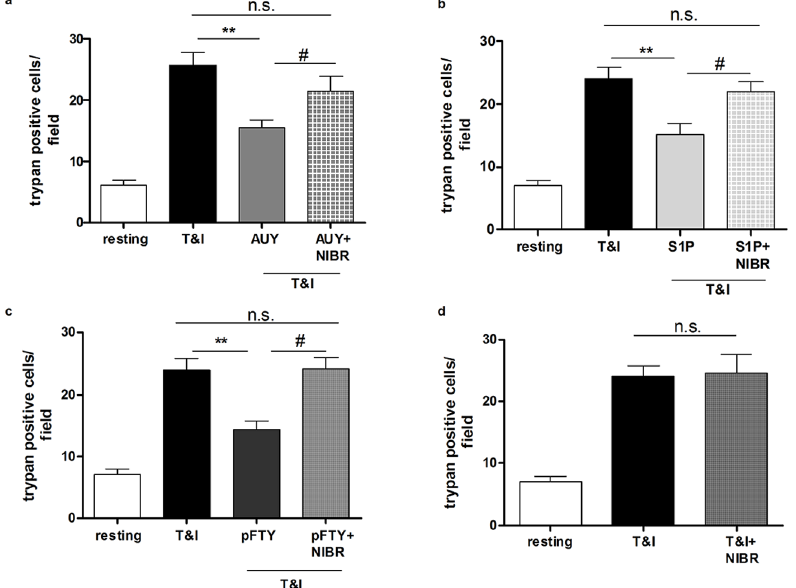
Fig 2. S1P 1 mediates hBMVEC survival after exposure to cytokines. a . The selective S1P 1 agonist, AUY- 954 (AUY, 50 nM) added together with TNF α (10 U/ml) and IFN γ (5 U/ml) (T&I), is able to counteract hBMVEC death induced by cytokines. The presence of S1P 1 selective antagonist NIBR-0213 (NIBR, 1 μ M) prevents this effect entirely. b. and c . The principal involvement of S1P 1 in the protective role of S1P (50 nM) and pFTY (50 nM) is further confirmed by the lack of their effects when used in combination with the antagonist NIBR (1 μ M). d . The specificity of S1P 1 antagonism is confirmed by the lack of any effect when NIBR is used in absence of any S1P receptor agonist. Data are the mean ± S.E.M. of four independent experiments, each run in triplicate, in which three to five fields per well were counted. ** p < 0.01 vs T&I, # p < 0.05 vs respective treatment in the absence of